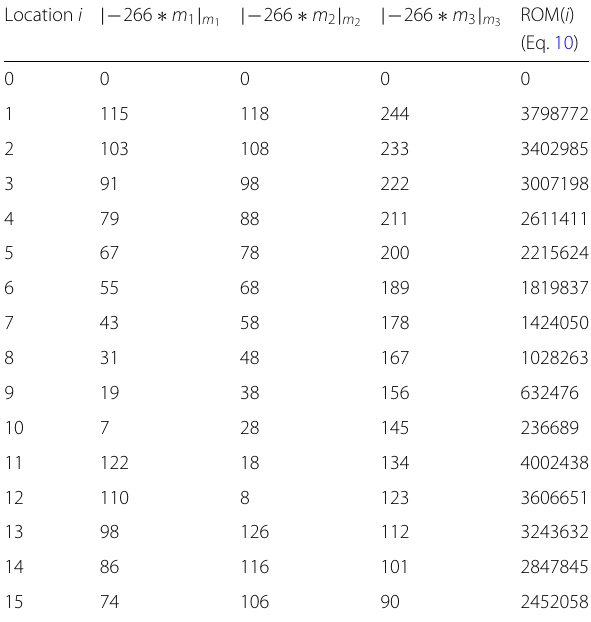
Table 1 The memory content of h 0 = − 0.1294 or 757 ( − 266 ) multiplied by 2 11 in P 7 = { 127, 128, 255 } when word length is